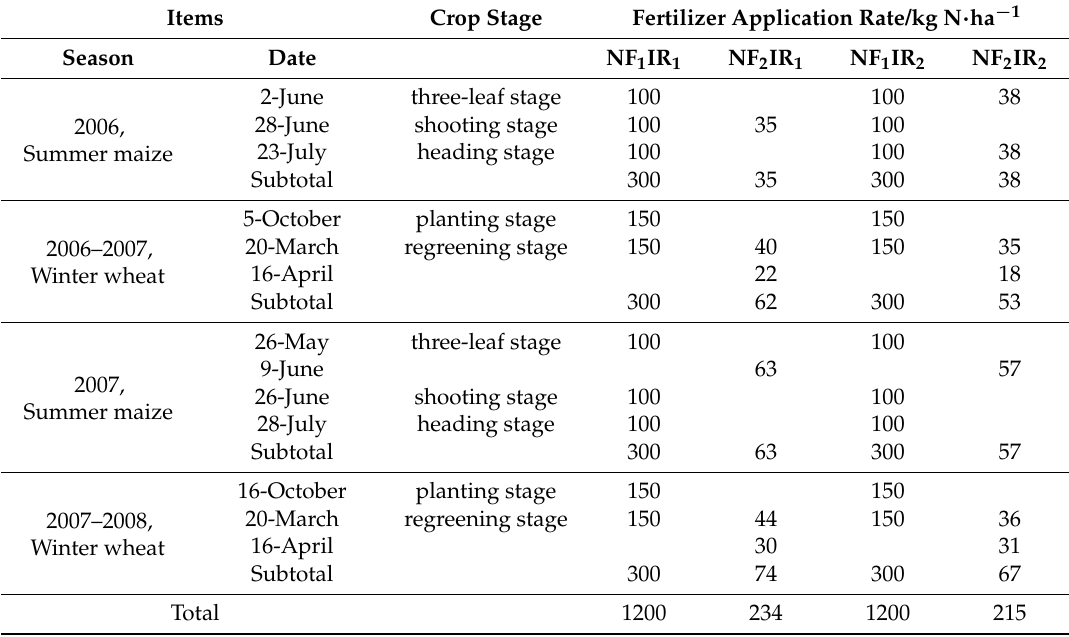
Table 1. N fertilization dates and rates under different management